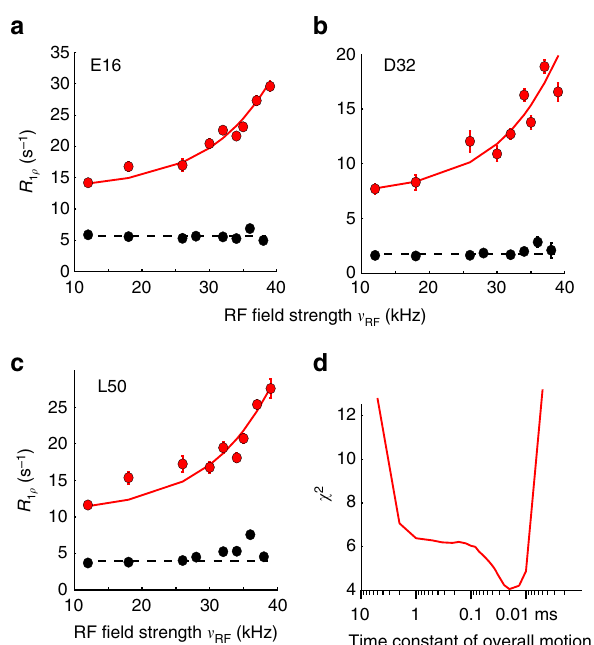
Fig. 3 Evidence for rocking motion in cubic-PEG-ub crystals from NERRD NMR measurements. a – c NERRD data of representative amide sites outside the dynamic β -turn region for MPD-ub ( black ) and cubic-PEG-ub ( red ). Error bars were obtained from Monte Carlo analysis, described in the Methods section. The solid red lines correspond to a two-state fi t of data from 22 amide sites with a common exchange time constant and per- residue-adjustable motional amplitude (all shown in Supplementary Fig. 6). d χ 2 value of this fi t as a function of the jump time constant. In fi tting these NERRD data, we have assumed that protein rocking can be approximated as two-site jump process, which is a crude but justi fi able model residues D52 and R54 in MPD-ub 35 , whereas all other residues showed either small NERRD pro fi les (residues I23, E51, T55) or no signi fi cant NERRD effect, mirroring the present data.